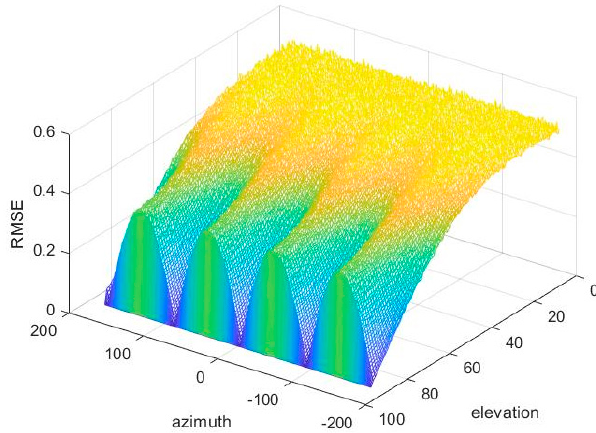
Figure 7. Root mean square error (RMSE) for different DOAs in degrees.